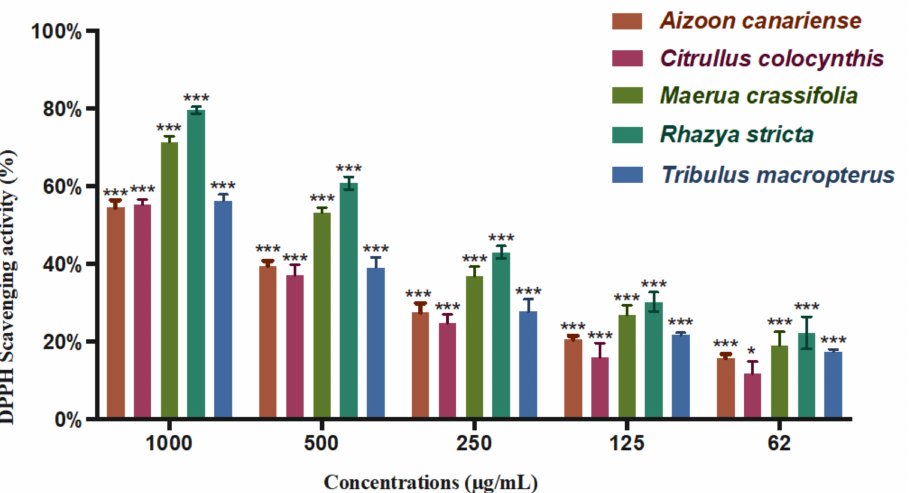
Figure 4. DPPH radical scavenging activity of the plant extracts at different concentrations ( µ g/mL) (mean ± S.D.). The results were obtained through three independent experiments. Statistical